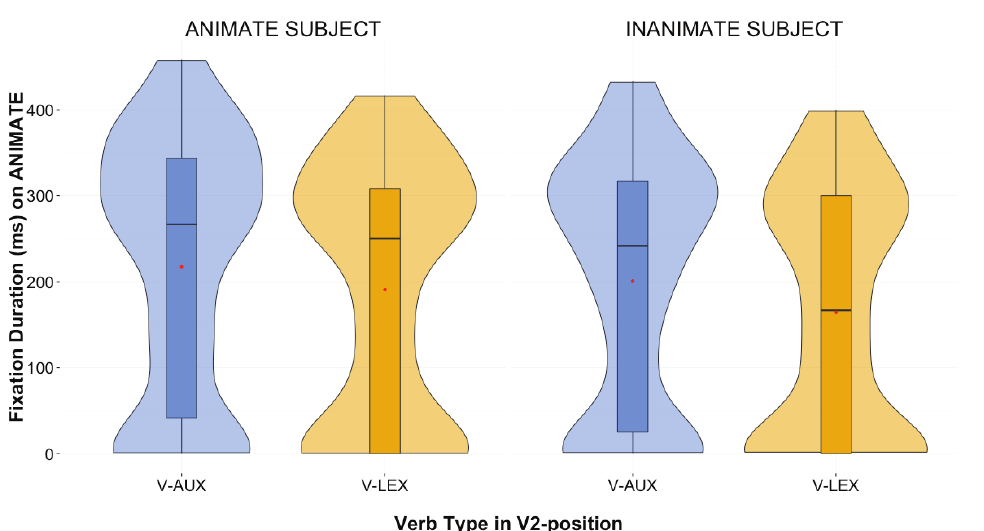
Figure 5: Violin/boxplot of fixation duration to the animate referent per condition in the early subject integration window. The red dot encodes the mean, the black vertical line encodes the median, the top and bottom edges of the box encode the interquartile range and the transparent beans provide a density plot. Note that the statistical analysis was performed on the logit-transformed odds ratio of fixations to the animate referent over those to the inanimate